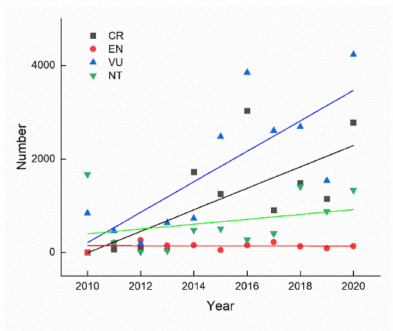
Figure 5. Bird numbers in relation to their IUCN red list status. Note: CR denotes critically en- dangered waterbirds; EN denotes endangered waterbirds; VU denotes vulnerable waterbirds; NT denotes near threatened waterbirds.